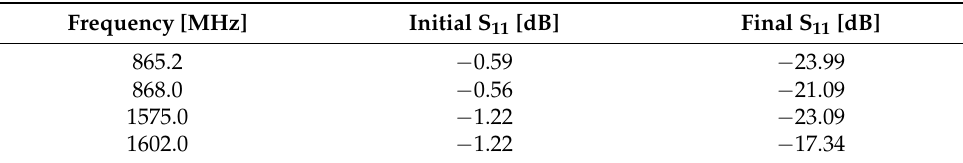
Table 1. Results of the matching and frequency-tuning